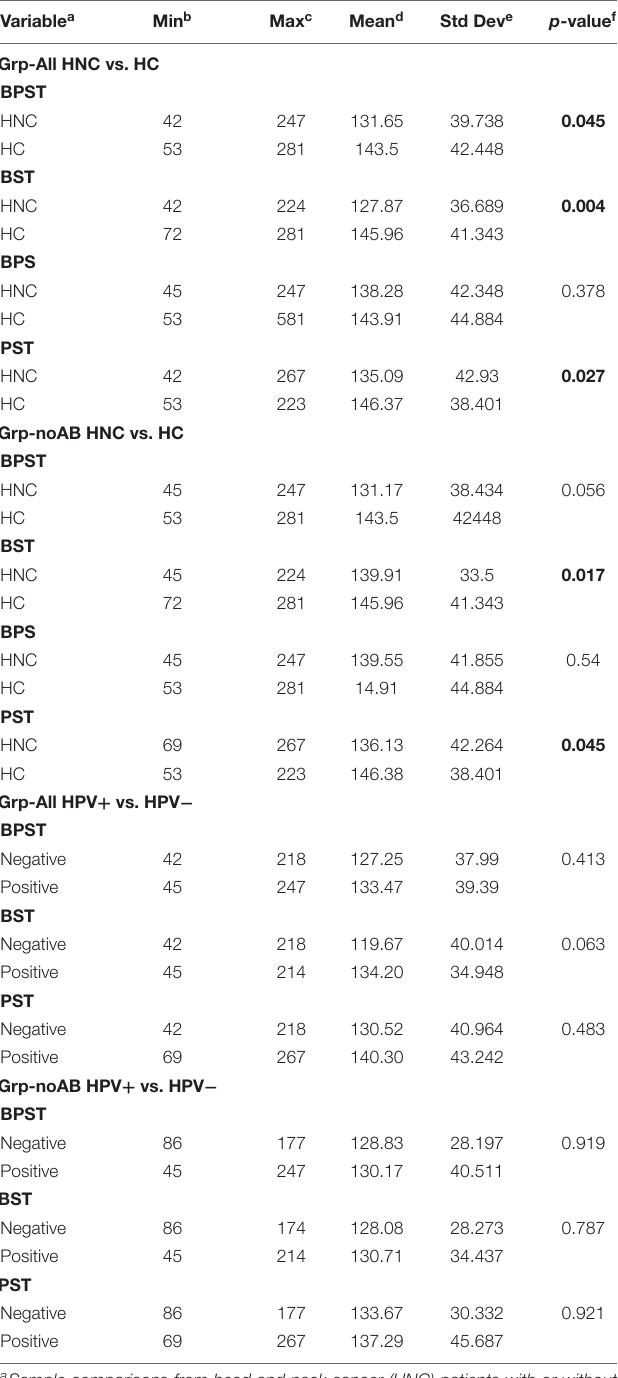
TABLE 2 | α -diversity comparisons: HNC vs. HC and HNC HPV + vs. HPV–. Variable